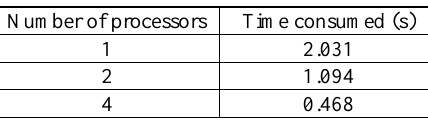
Table 9. Amount of time spent